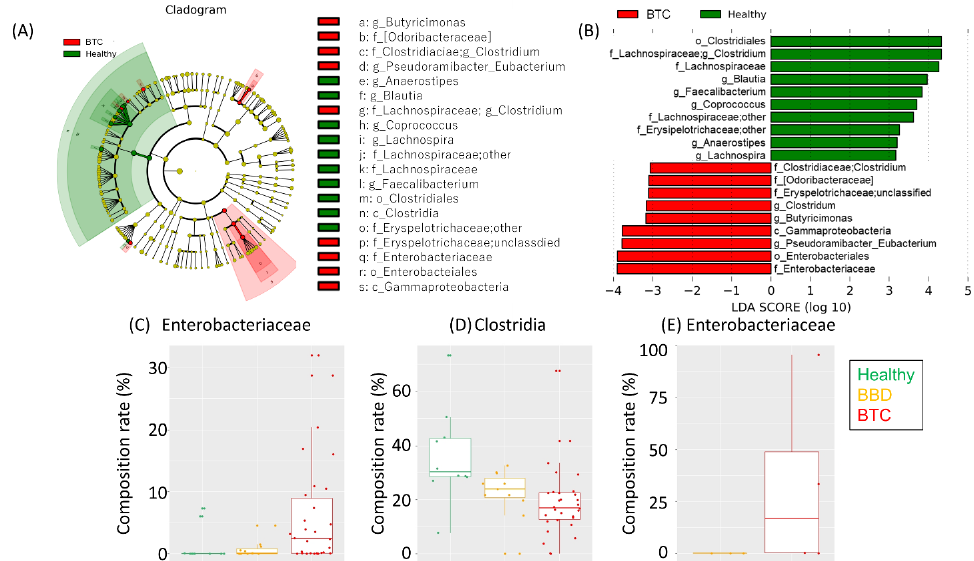
Figure 3. Characteristics of the fecal microbiota in each group. ( A ) Cladogram and ( B ) LDA score based on LEfSe of the fecal microbiota composition of ( C ) Enterobacteriaceae and ( D ) Clostridia. ( E ) OTUs assigned to Enterobacteriaceae between the bile samples from the BBD and BTC groups. The LDA scores and compositions of Enterobacteriaceae are shown. Notably, some butyrate-producing bacteria, such as Faecalibacterium and Coprococcus , were enriched in the healthy group. No apparent difference was observed in the alpha S2).